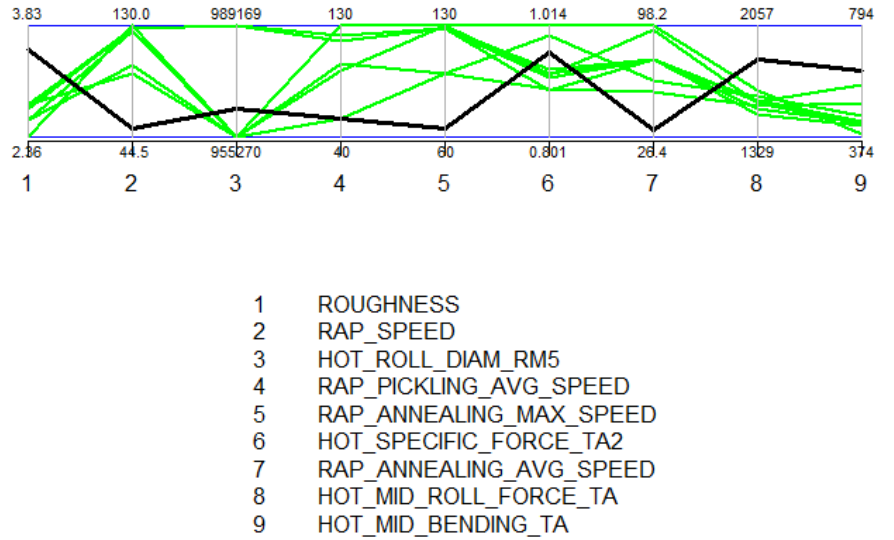
Figure 17. Parallel coordinates for a product with an increased risk of roughness (solid black) compared to the set of good products (green).